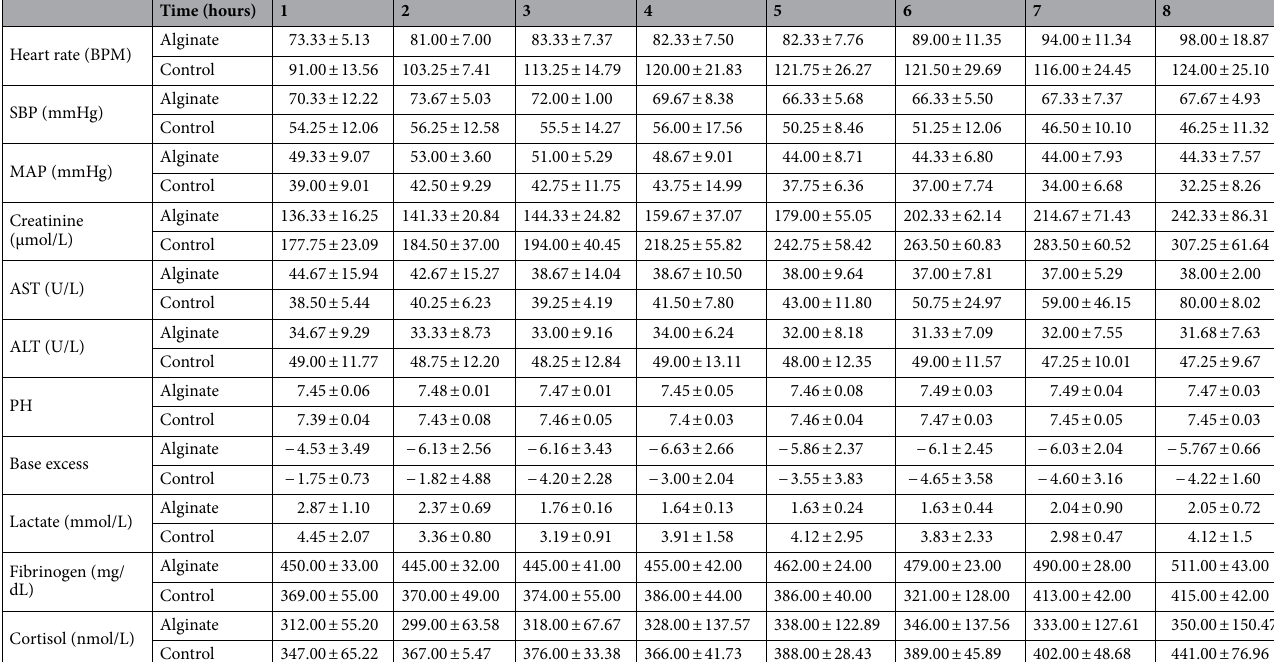
Table 1. Mean values (± SD) of variables recorded during 8 h of the experiment. Included are values at each time point between VLVG alginate and the control groups. Each panel represents the mean value of the measured parameter at that specific time point ± standard